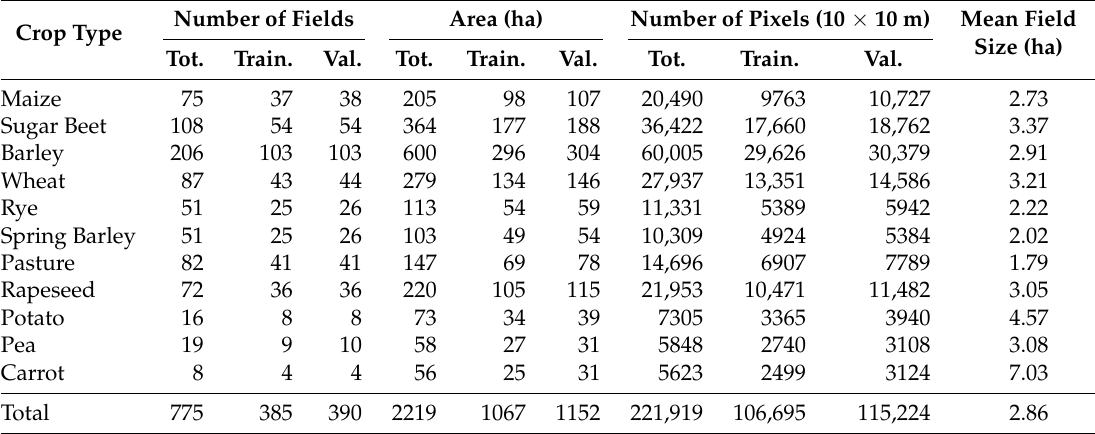
Table 3. Collected field data of crop distribution during the growing season